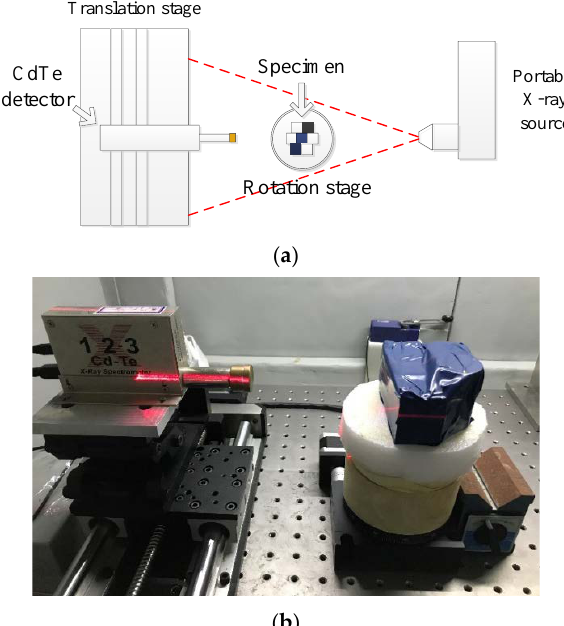
Figure 3. ( a ) Design of schematic of CT reconstruction experiment ( b ) Sealed specimen under experimental condition